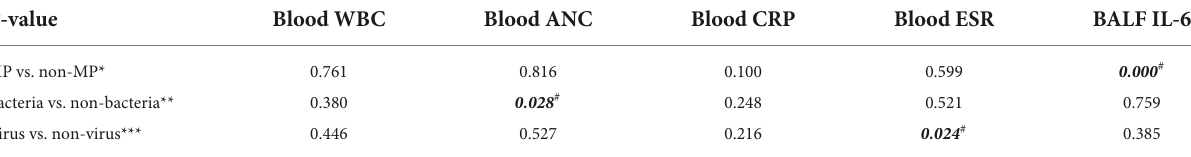
*MP vs. non-MP: cases with Mycoplasma pneumoniae detected vs. cases without Mycoplasma pneumoniae detected, including bacteria, virus, and no pathogen detected. **Bacteria vs. Non-bacteria: cases with bacteria detected vs. cases without bacteria detected, including MP, virus, and no pathogen detected. ***Virus vs. Non-virus: cases with virus detected vs. cases withoutvirusdetected,includingMP,bacteria,andnopathogendetected. # Significantdifferences(p < 0.05)areboldanditalicized.